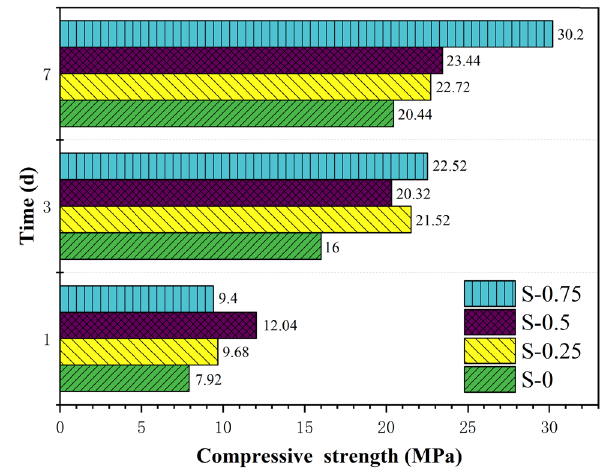
Figure 2: Autogenous shrinkage of cement paste added with dif - ferent dosages of nano - C – S – H.